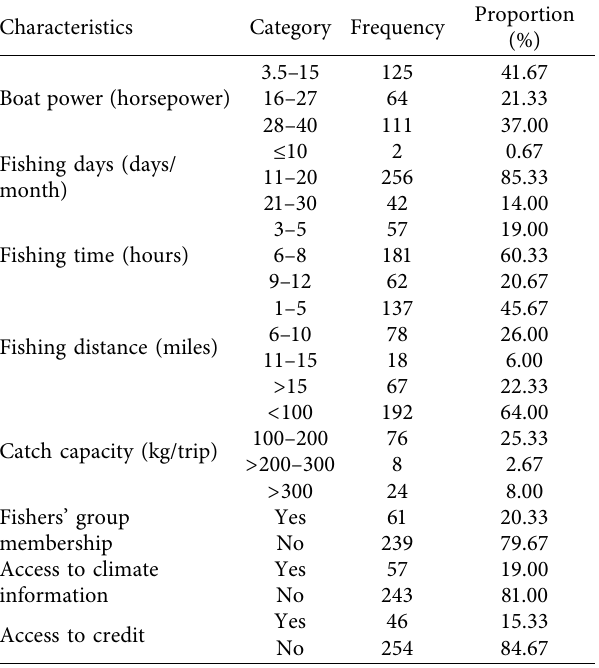
Table 4: Small-scale fshery characteristics ( n � 300).